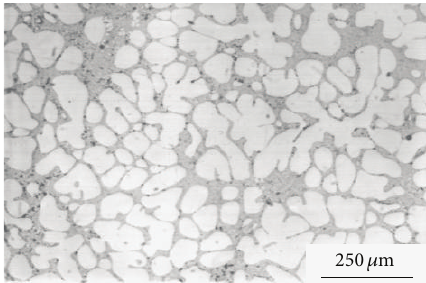
Figure 21: Microstructure of alloy A356 obtained by the DTM [46].